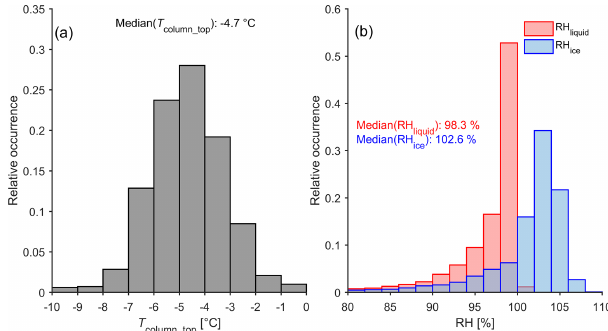
Figure 3. Duration of cloud observations (bars) and occurrence of columnar-ice-producing clouds (red dotted curve) over Hyytiälä as a function of cloud top temperature (CTT). The results were calcu- lated based on the data collected from February 2018 to April